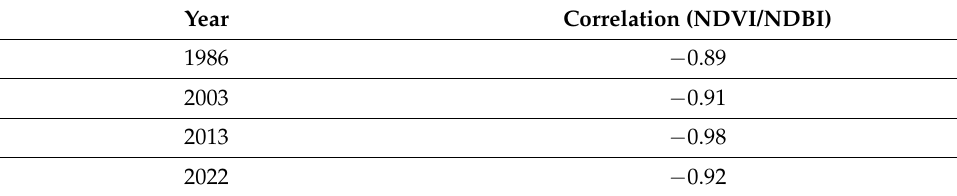
Table 4. NDVI–NDBI Correlation.